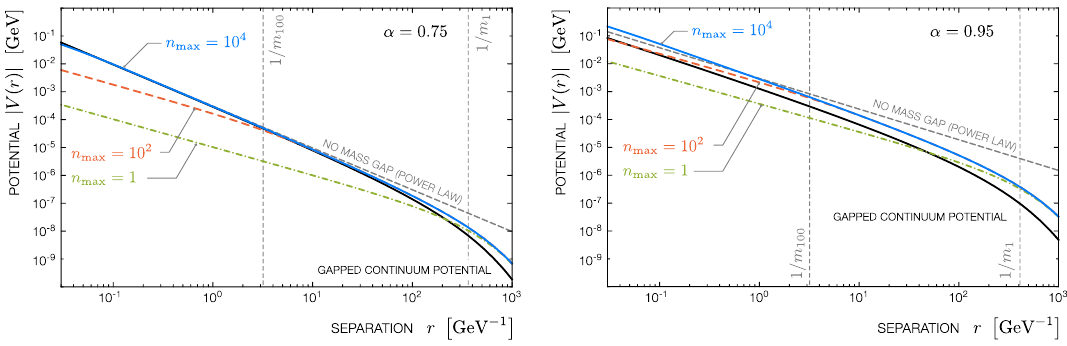
Figure 2 . Absolute potential | V ( r ) | plotted to validate the continuum-mediated potential with a mass gap (black) against a sum over n max Kaluza-Klein modes (colored). The potential with n max KK modes is valid for separations larger than r & m − 1 . The disagreement at long separations n max between the blue and black lines represents our numerical error and does not change the quantitative behavior of integrals over the potential. Also shown: the non-integer power law limit (dashed gray) that is realized in the gap-less limit m 1 → 0